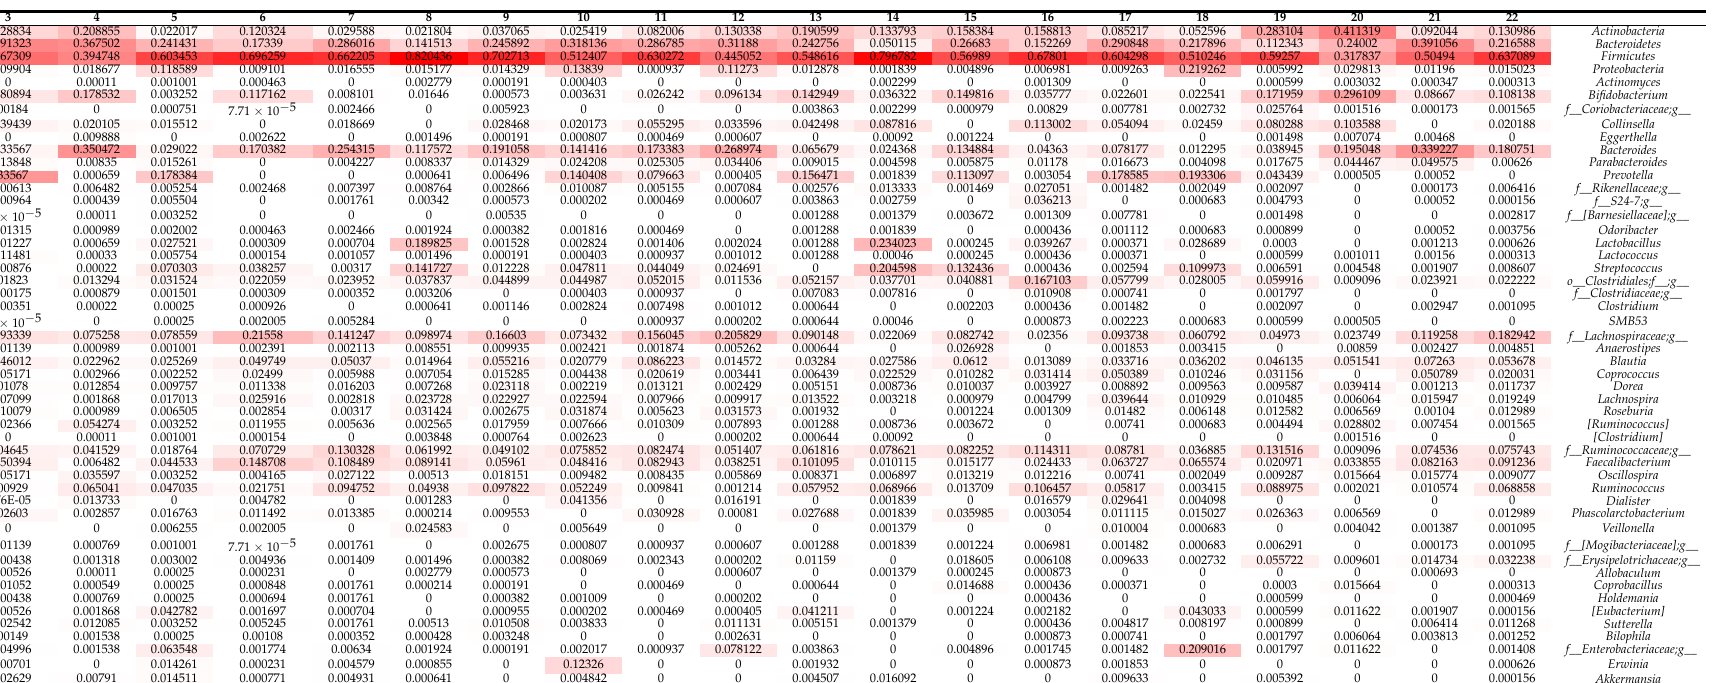
Table 2. Composition of the gut microbiota in each